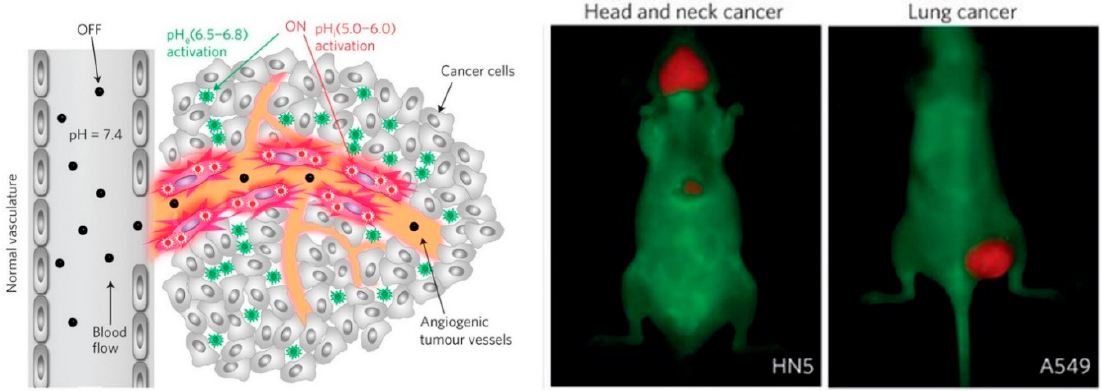
Figure 13. pH-activatable nanoparticles for tumor-specific fluorescent imaging. (Left panel) The nanoparticles stayed in micelle state in normal physiological pH and the fluorescence was quenched as a result of self-quenching Forster resonance energy transfer (HomoFRET) effect. Upon exposure to acidic tumor microenvironment, protonation of tertiary amines lead to the dissociation of micelles and resume of fluorescence. (Right panel) pH-responsive nanoparticles selectively light up tumors instead of surrounding normal tissues in various tumor models. Reproduced with permission from Yiguang